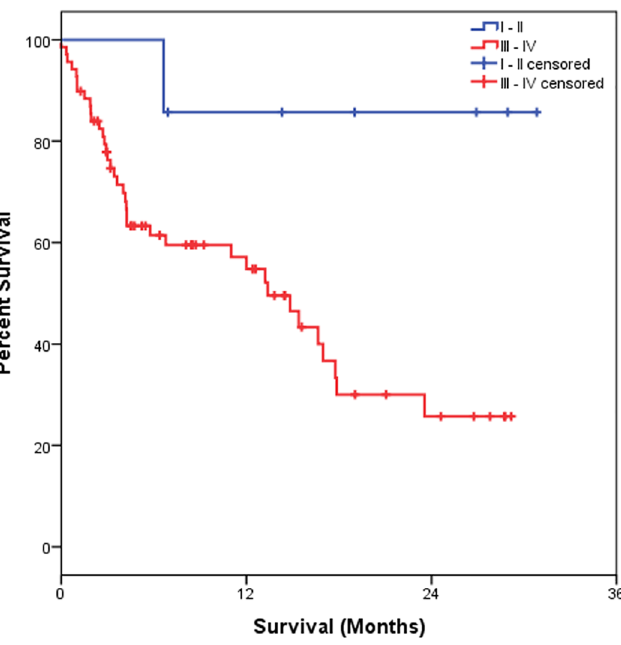
Fig 3. Kaplan-Meier survival estimatesby stratification of TNM stage in NSCLC patients.